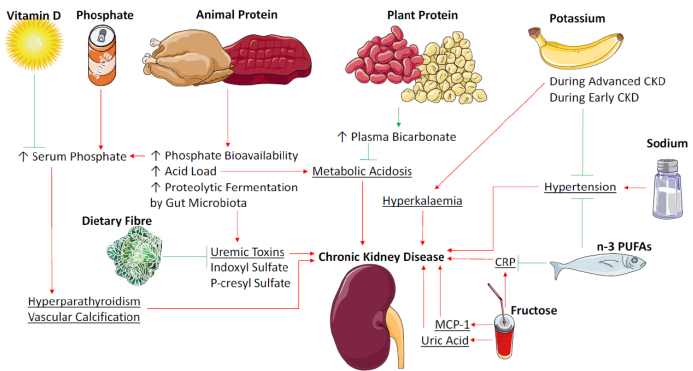
Figure 1. Mechanisms of dietary factors impact on chronic kidney disease. n ‐ 3 PUFAs = Omega 3 Polyunsaturated Fatty Acids. CRP = C ‐ Reactive Protein. MCP ‐ 1 = Monocyte Chemoattractant Protein ‐ 1.